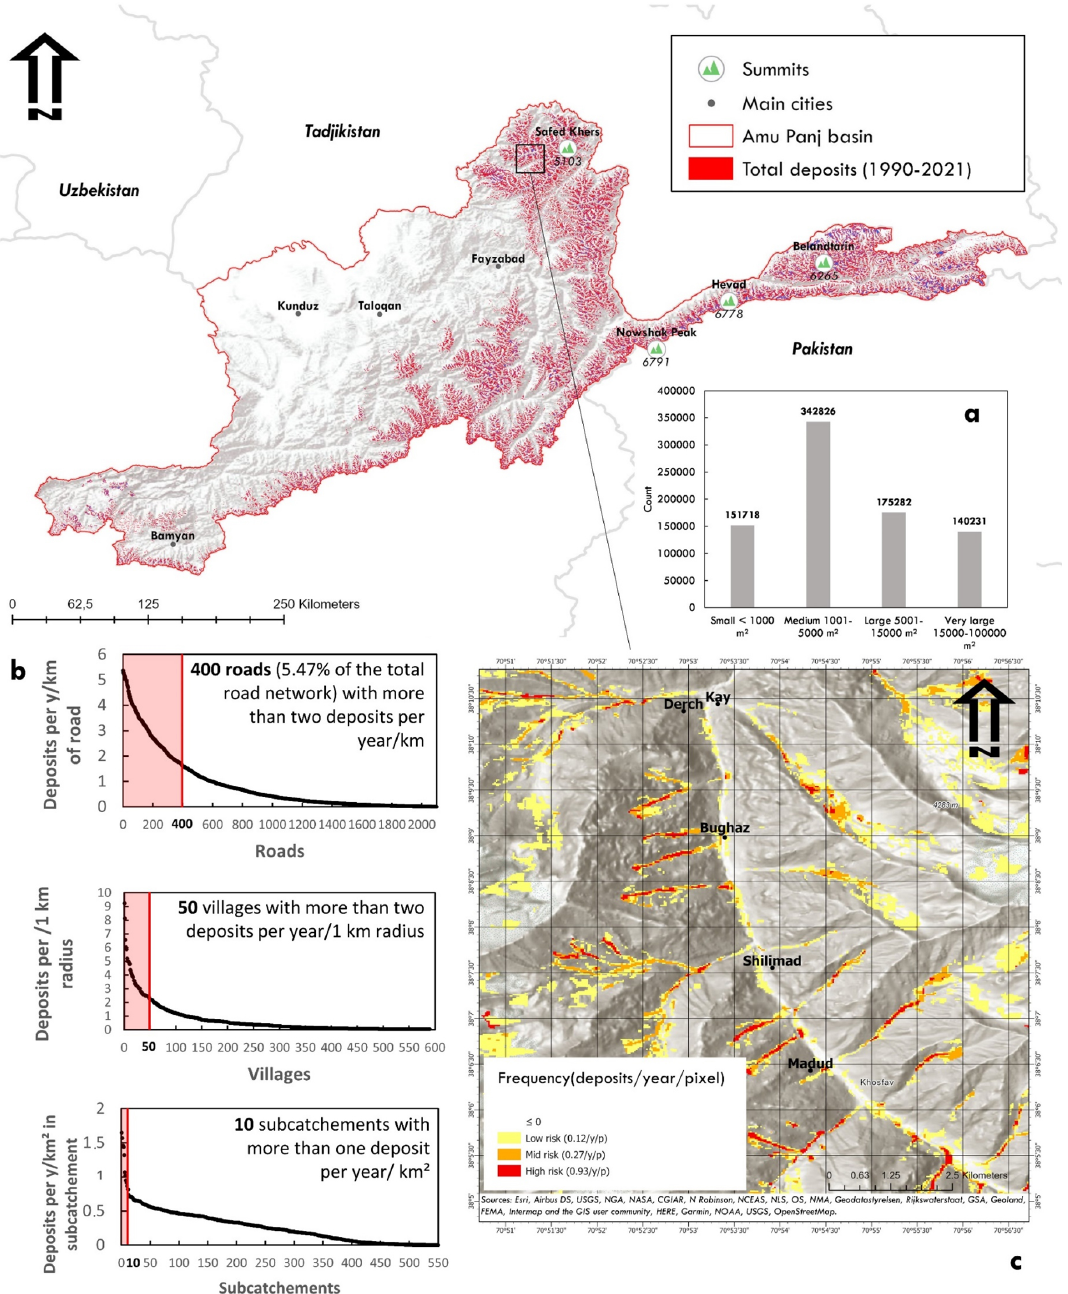
Figure 6. Yearly inventory map of snow avalanche depositional zones in the Amu Panj basin: 1990–2021. (a) Surface area classification of avalanche depositional zone frequency. (b) Avalanche depositional zone frequency per number of roads, villages, and subcatchments in the basin. (c) An example map of avalanche depositional zone frequency during the 32-year period at a village